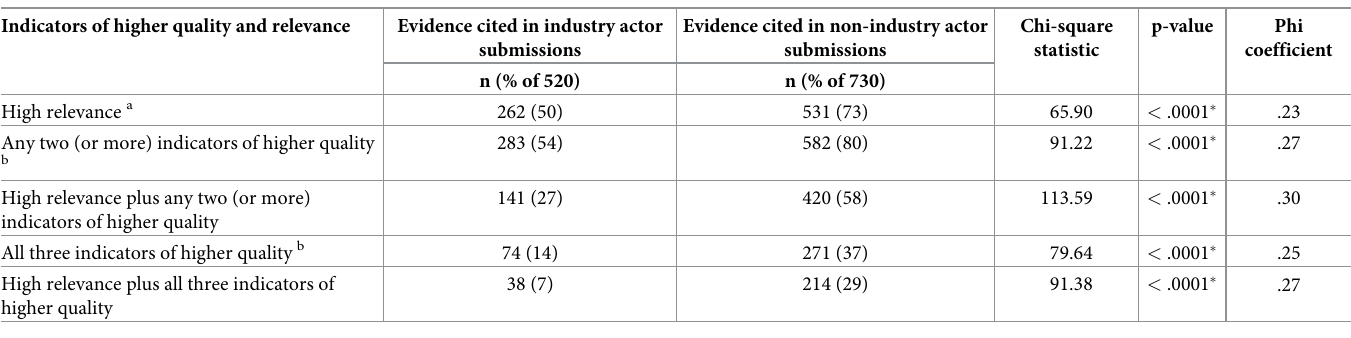
Table 4. Proportions of evidence with indicators of higher quality and